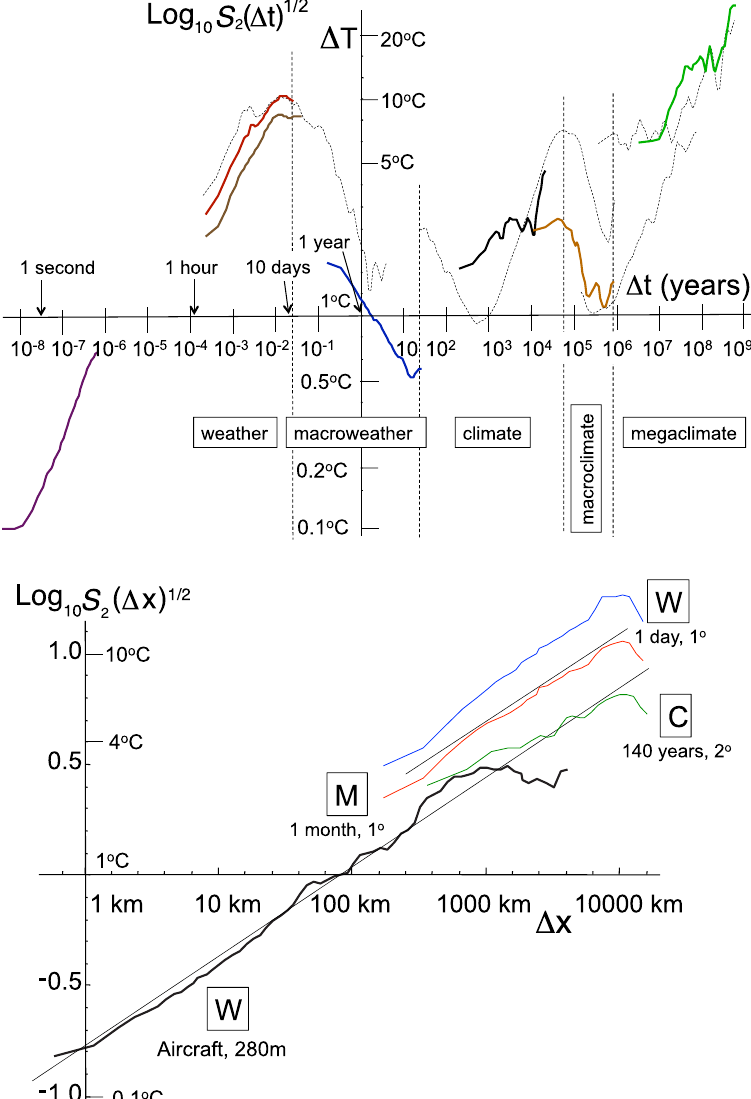
Figure 1. (a) (top panel): A wide scale range composite of temporal Root Mean Square (RMS) Haar temperature fluctuations with the data described in Table 1 in thick lines (from left to right, the solid curves are data set #1, bottom, #2, top #3), #4, #5, #7, #8). The dashed lines are reproduced from ref. 2 left to right, datasets #2, #6, #7, #8. Here as in b, the fluctuations were multiplied by the canonical calibration constant of 2 so that when the slopes are positive, the fluctuations are close to difference fluctuations. The various scaling regimes are indicated at the bottom. (b) (bottom panel): Same as ( a ) but for spatial transects. The bottom aircraft (data set #9) and top (daily resolution, data set #10) data are in the weather regime (“W”), the line labelled “M” is in the macroweather regime (data set #11), and the one labelled (“C”), the climate regime (data set #12, see Table 1 for details). At scales >≈ 2500 km, the aircraft fluctuations from a single flight, have a dip caused by poor statistics. The breaks in the other (weather, macroweather and climate) transects only occur at scales of about 10,000 km (upper